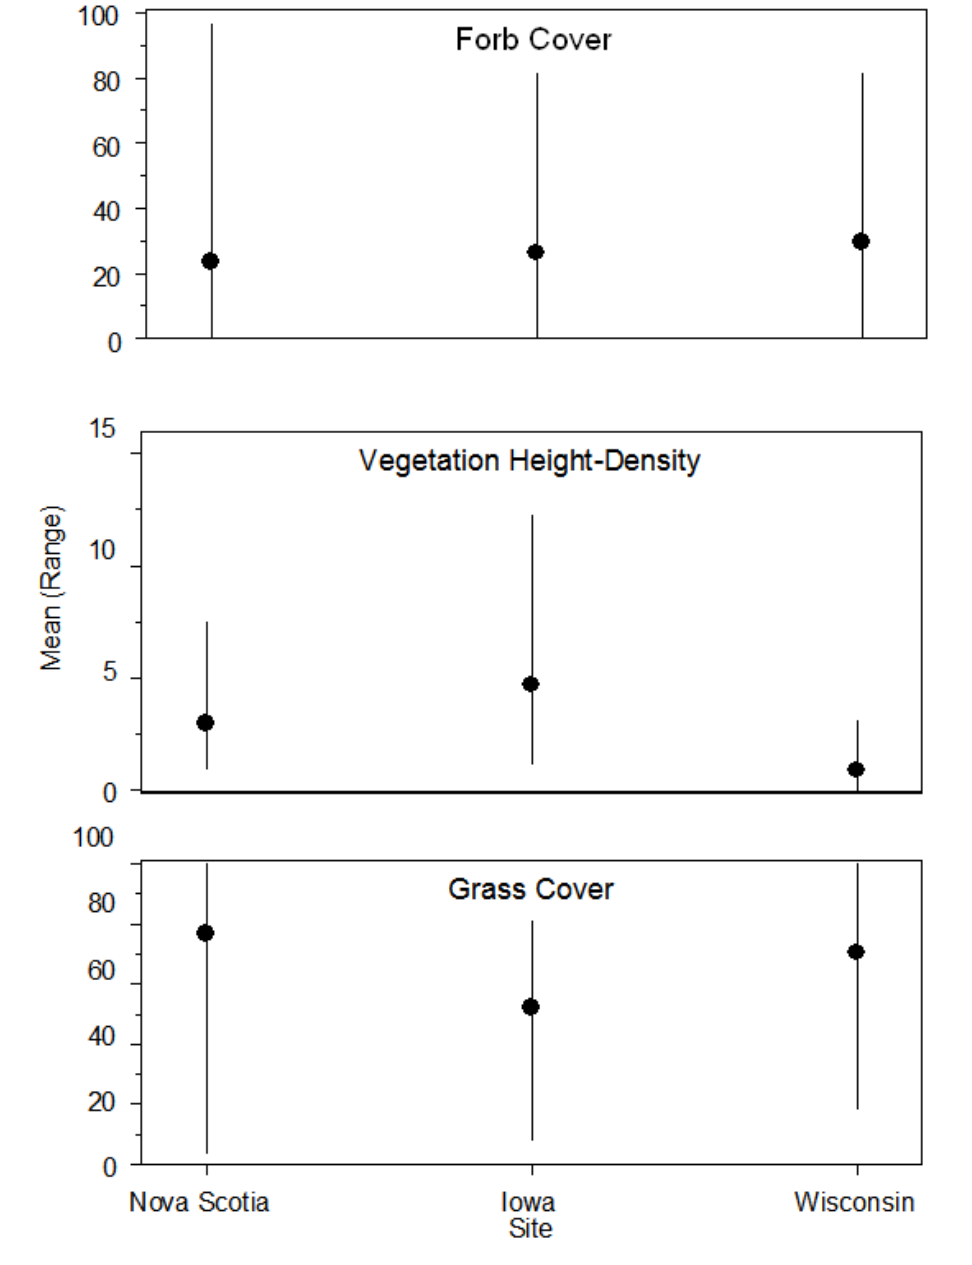
Fig. 2. Vegetation characteristics (mean and range) at three grassland sites in North America as reported by Nocera et al. (2007). The whiskers represent the range. The reported upper maximum forb cover in Iowa was incorrectly reported, i.e., it was smaller than the mean, but I have imputed a reasonable value for this